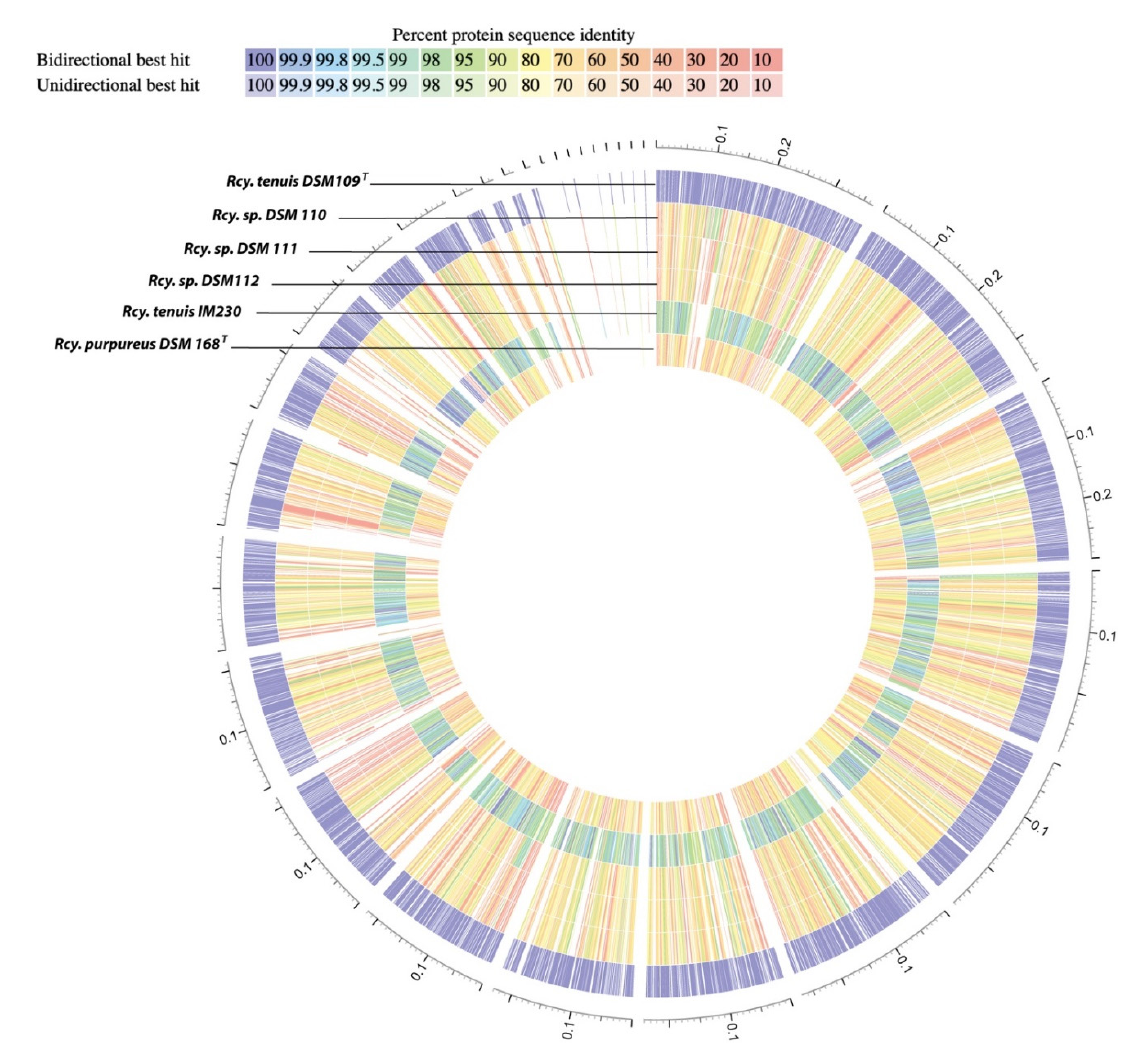
Figure 2. Proteome comparison of Rhodocyclus species and relatives based on protein-sequence-based genome comparison using bidirectional BLASTP. Rcy. tenuis DSM 109 T was used as the reference proteome. The percent protein identity is color-coded for each proteome as compared to the reference proteome. Rcy. tenuis IM 230 showed average amino acid identities (AAI) of 97.6% (blue-green), while the Rcy. DSM 110, Rcy . DSM 111, Rcy. DSM 112, and Rcy. purpureus proteomes are equidistant from the reference proteome (77–78% identity; yellow ‐ orange).